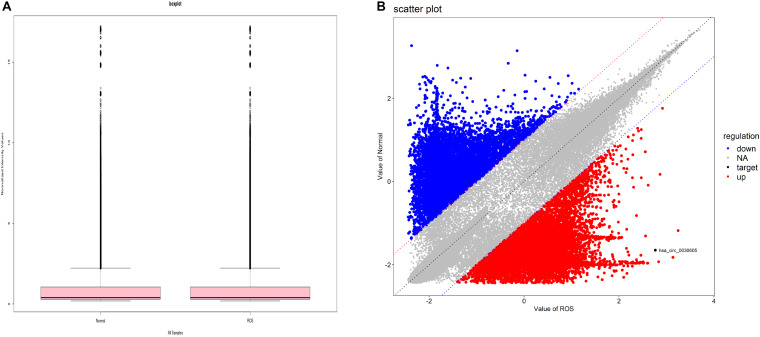
circRNA expression profile in BPD. (A) Boxplot, a method of describing data in terms of minimum, first quartile (25%), median (50%), third quartile (75%), and maximum. the abscissa is the sample name, and the ordinate is the value of the signal value of the probe after log2. The upper and lower sides of the rectangular box correspond to the upper and lower quartiles of the data (Q1 and Q3). The median line inside the rectangular box is the median, the upper line is Q1+1.5IQR, and the underline is Q3-1.5IQR, where IQR (Inter) Quantile Range) is the middle quartile range, IQR = Q3-Q1. (B) Each dot in the scatter plot represents the probe point on the chip. The x-axis represents the signal value after this point is normalized in the control chip. The y-axis represents the signal value after the point is normalized in the sample chip. The point on the y = x line (the median line on the graph) in the graph, which represents the probe point Fold Change = 1 in both chips. A point that falls outside the 45° line on either side of the bit line in the graph, which represents the probe point Fold Change > 2 in both chips. The red circles in the plot represent the upregulated circRNAs, and the blue circles in the plot represent the downregulated differentially expressed circRNAs with statistical significance.